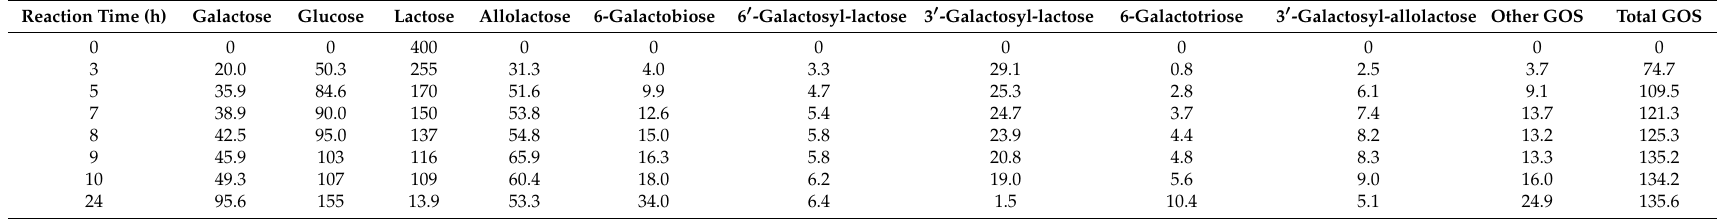
Table 1. Carbohydrate composition (g/L) in function of the reaction time using P. anthophila Bac 55.2 permeabilized cells as a biocatalyst a .